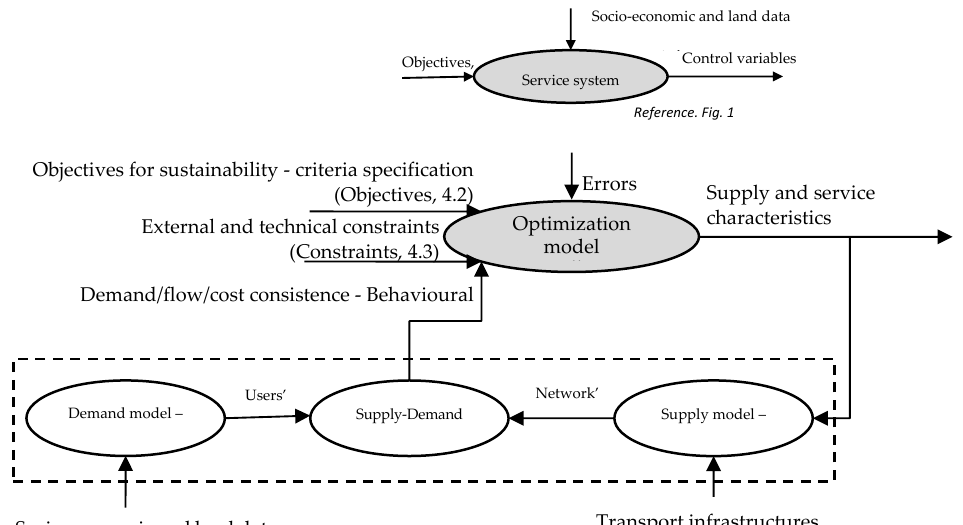
Figure 2. Transport System Models for services design (controller).